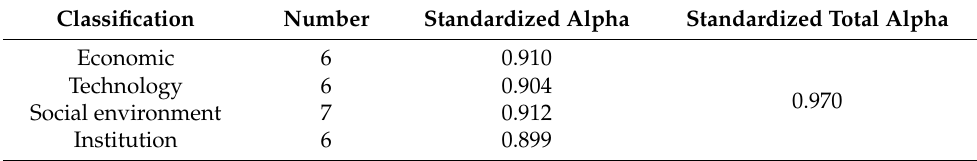
Table 3. Reliability analysis of hindering